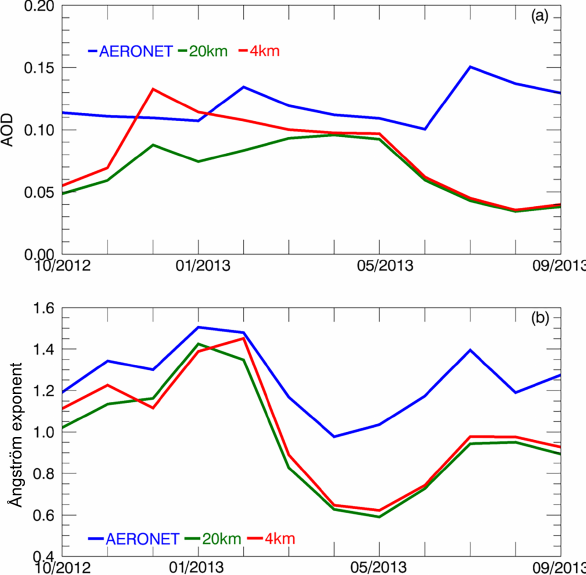
Figure 4. (a) Monthly mean 550nm AOD; (b) monthly mean 400– 600nm Ångström exponent at Fresno, CA, from October 2012 to September